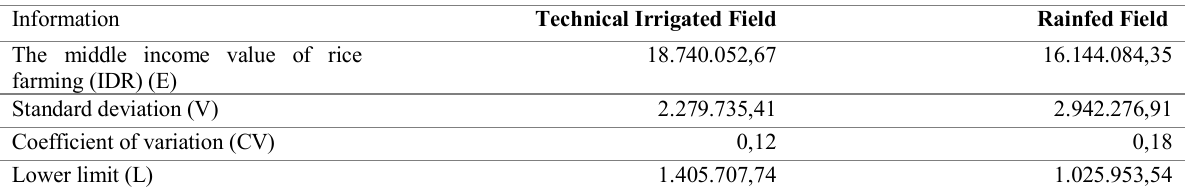
Table 3: Income Risk for Rice Farming on Technical Irrigated Rice Field and Rainfed Rice Field In South Lampung